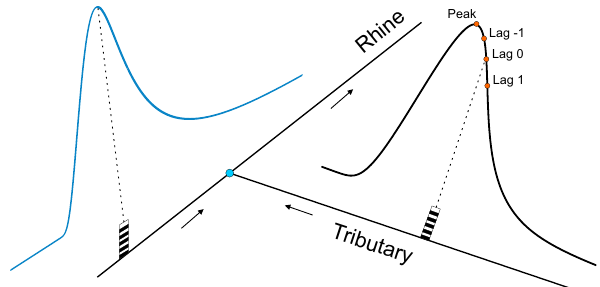
Fig. 5. Schematic representation of a possible matching of Rhine and tributary hydrographs and indication of the extracted tributary time